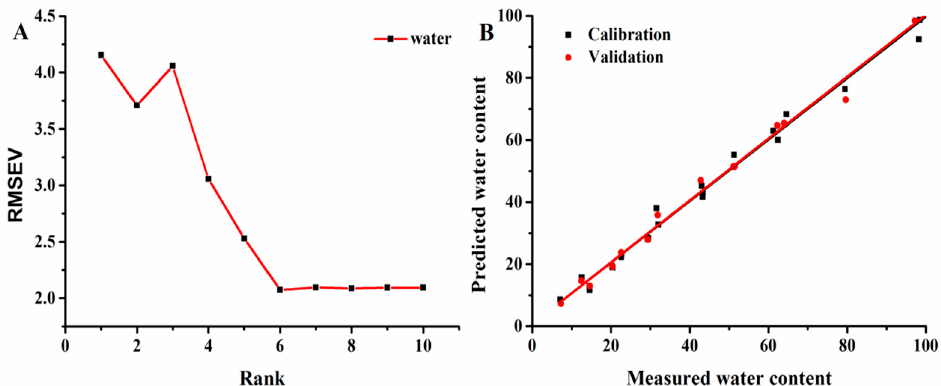
Figure 6. RMSEV of calibration vs. ( A ) rank values and ( B ) the measured and predicted plots of the PLSR models for water in G. elata